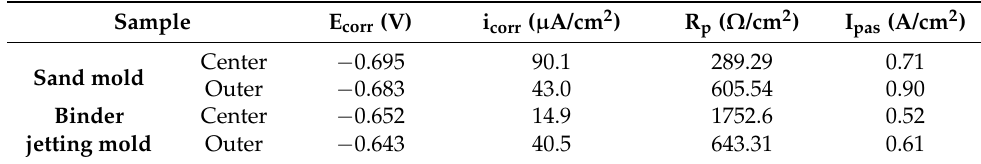
Table 6. Electrochemical parameters estimated by Tabel